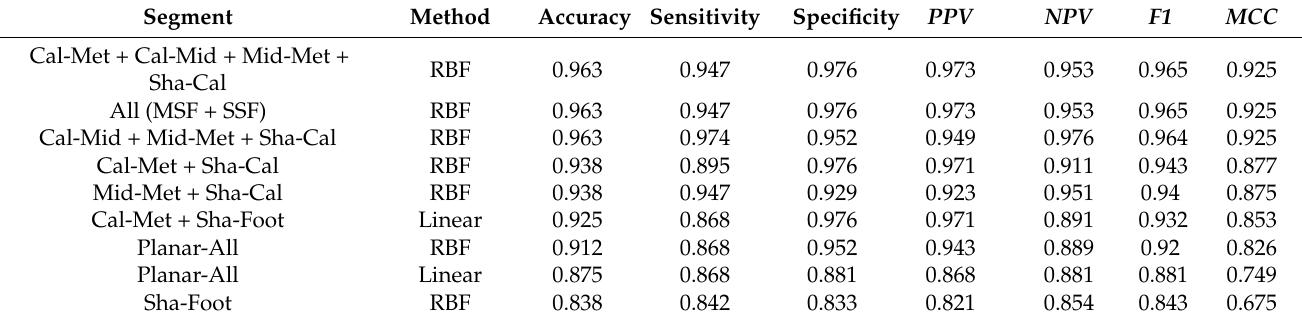
Table 5. Summary of top-performing